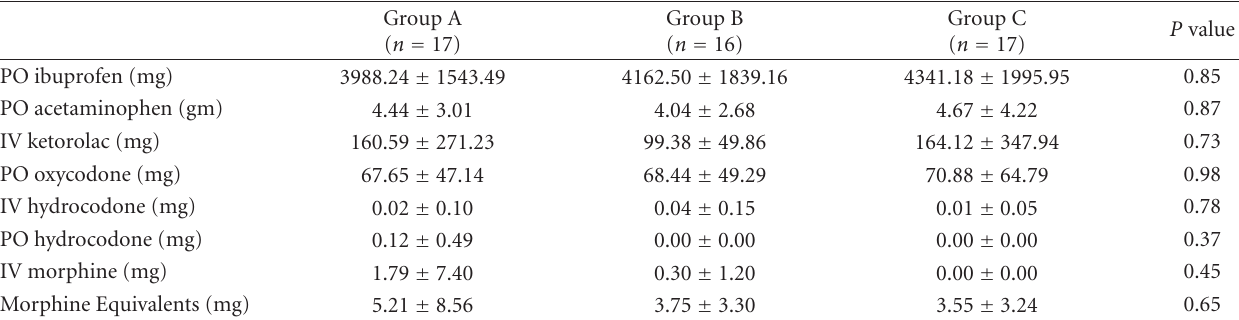
Table 2: Total consumptive postoperative analgesic